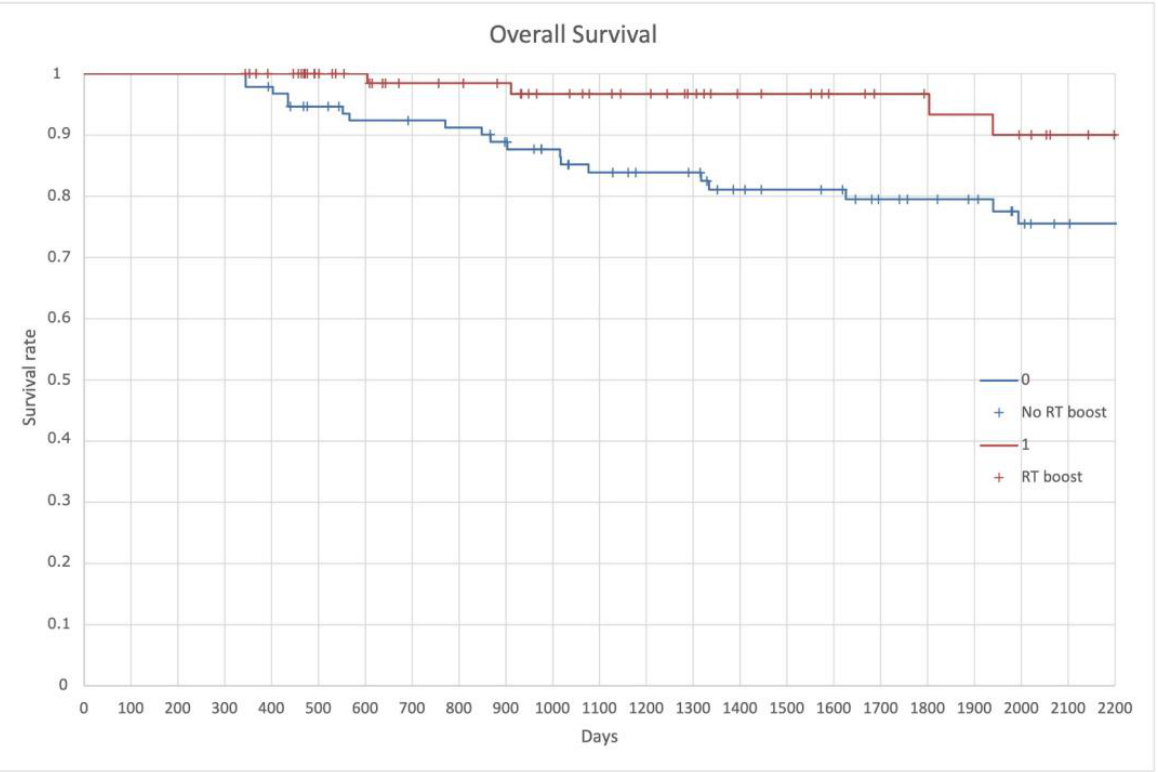
Figure 5. Disease Free Survival (DFS). Distant metastasis appeared in 15.9% of the entire population; patients in the no RT group had higher risk to develop distant metastasis (22.3%) than in the RT boost group